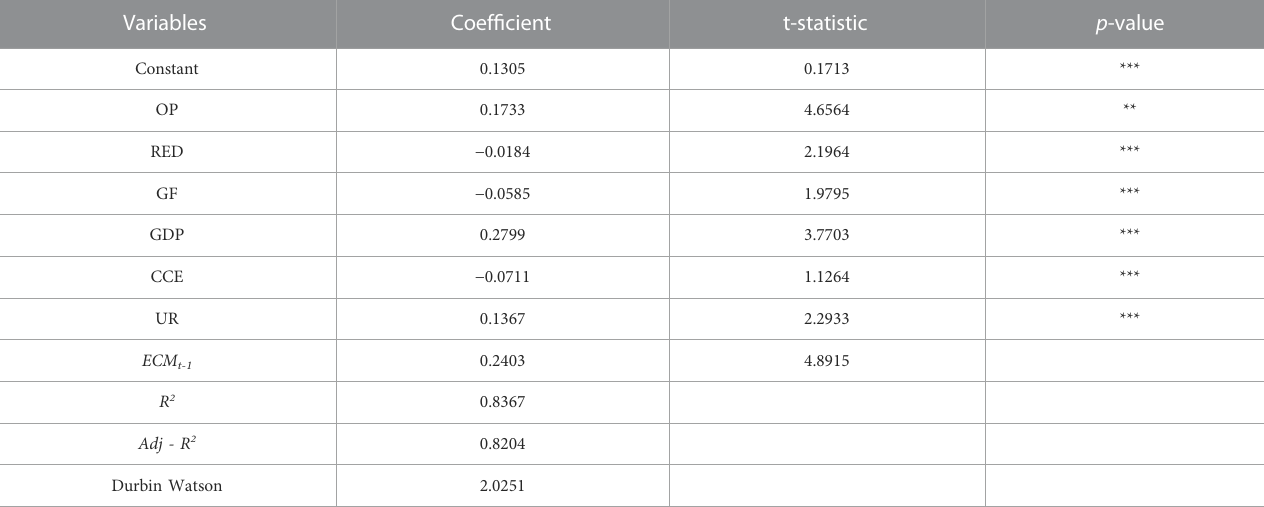
TABLE 8 Results of Long-run estimations of ARDL.